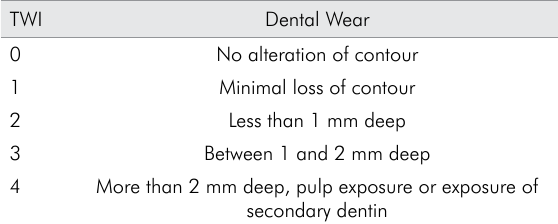
Table 1. The tooth wear index